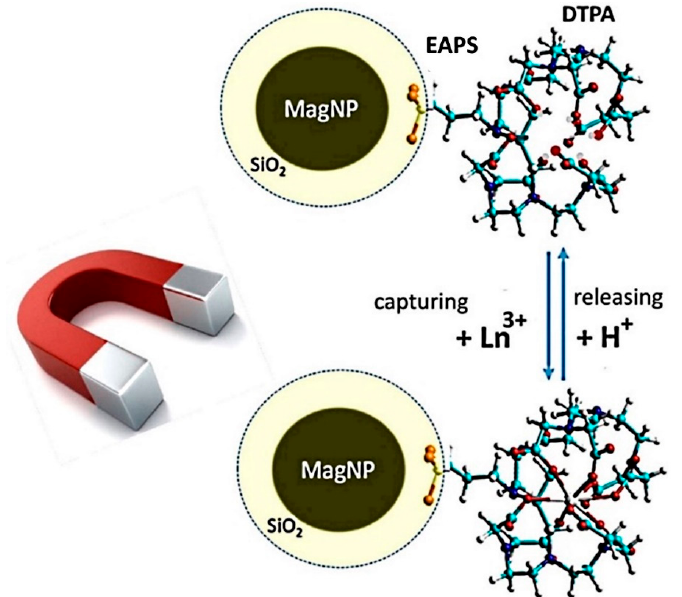
Figure 20. Magnetic capture and releasing of lanthanide ions by the superparamagnetic nanoparticles functionalized with DTPA (adapted with permission from [44]).